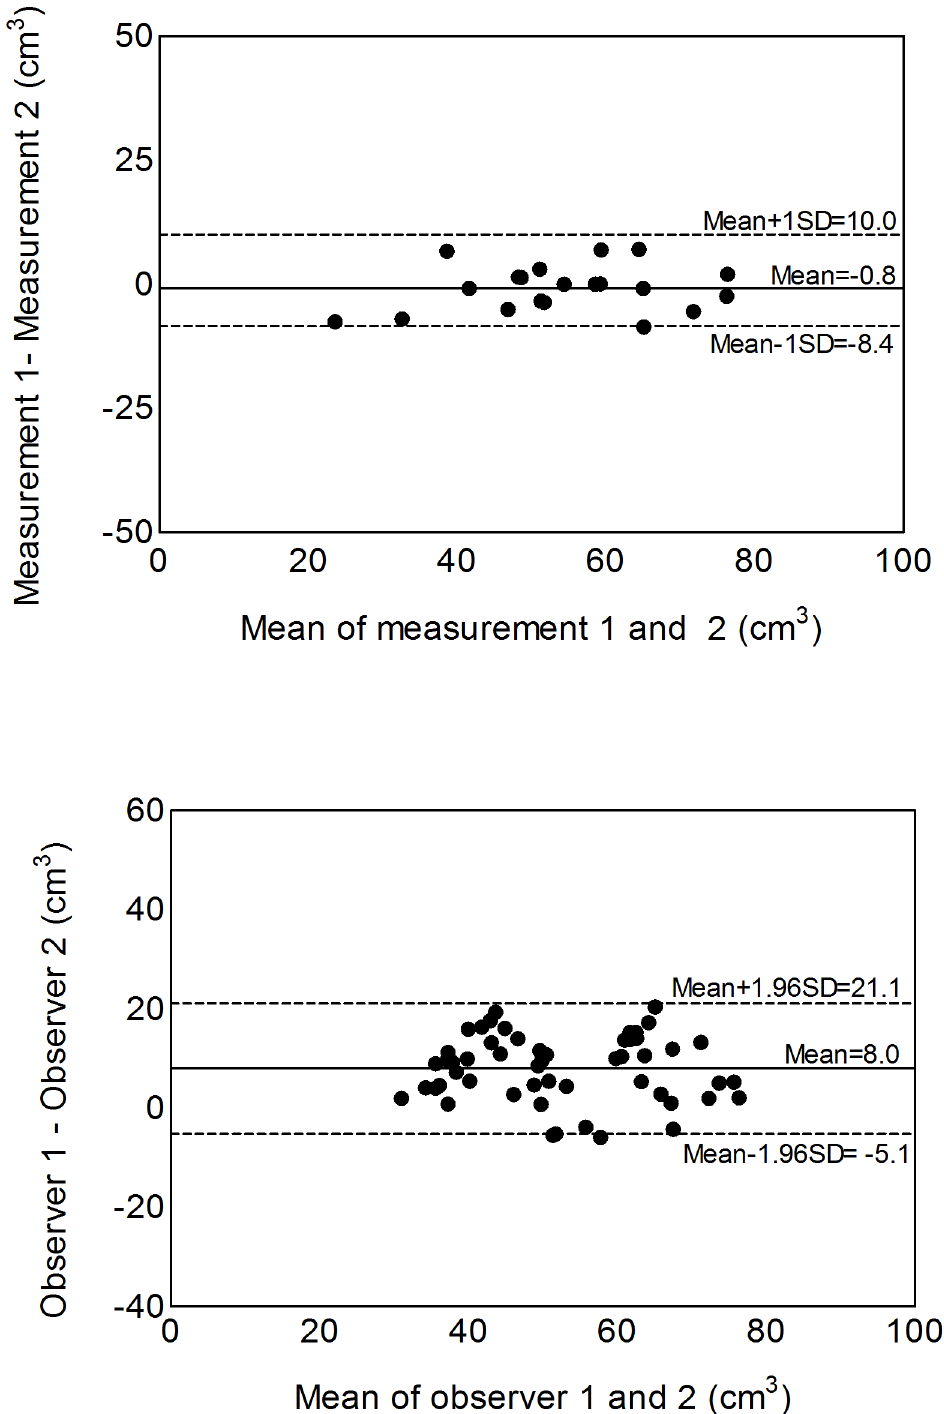
Fig 3. Bland-Altman plots for intra-observer (panel a) and inter-observer (panel b) analysis of pancreas volume measurement (cm 3 ). The Bland Altman statistic confirmed lack of bias and defined 95% limits of